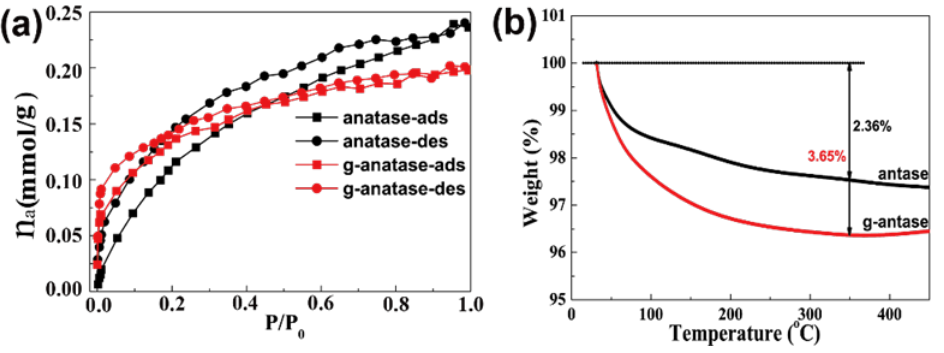
Figure 7. ( a ) CO 2 adsorption and desorption curves and ( b ) TGA curves of anatase and colored anatase samples.